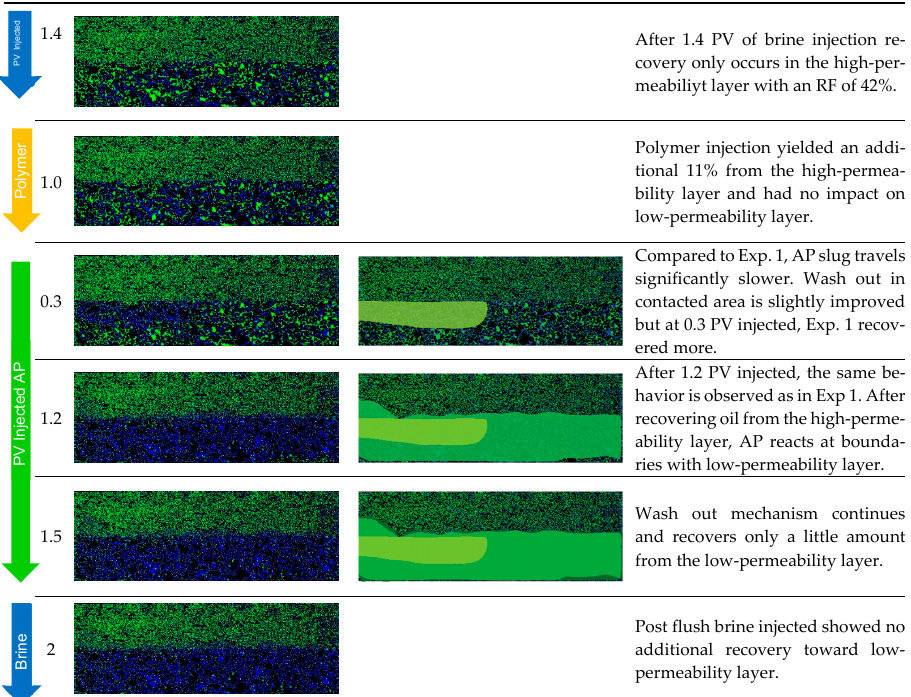
Figure 13. Displacement fronts during each slug injection in Exp. 3 (left: segmented images after analysis; right: post-edit images highlighting displaced area).